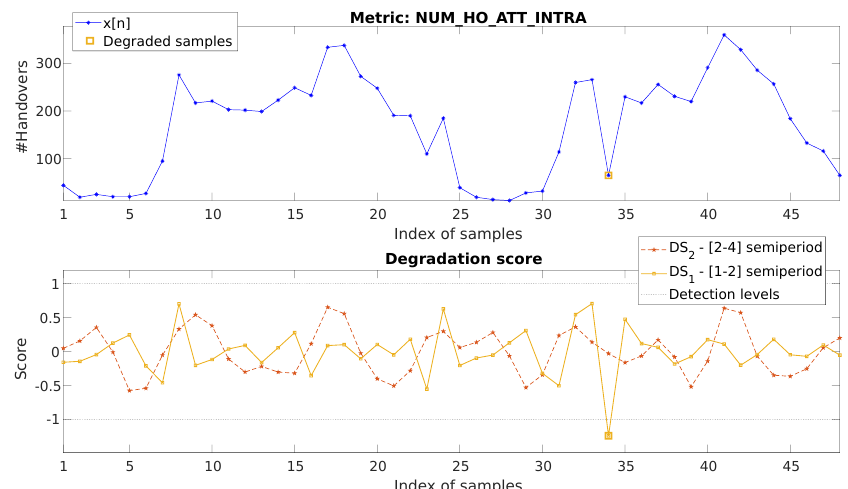
Figure 10. Two-day data of the hourly metric NUM_HO_ATT_INTRA and its decomposition and detection process following the proposed